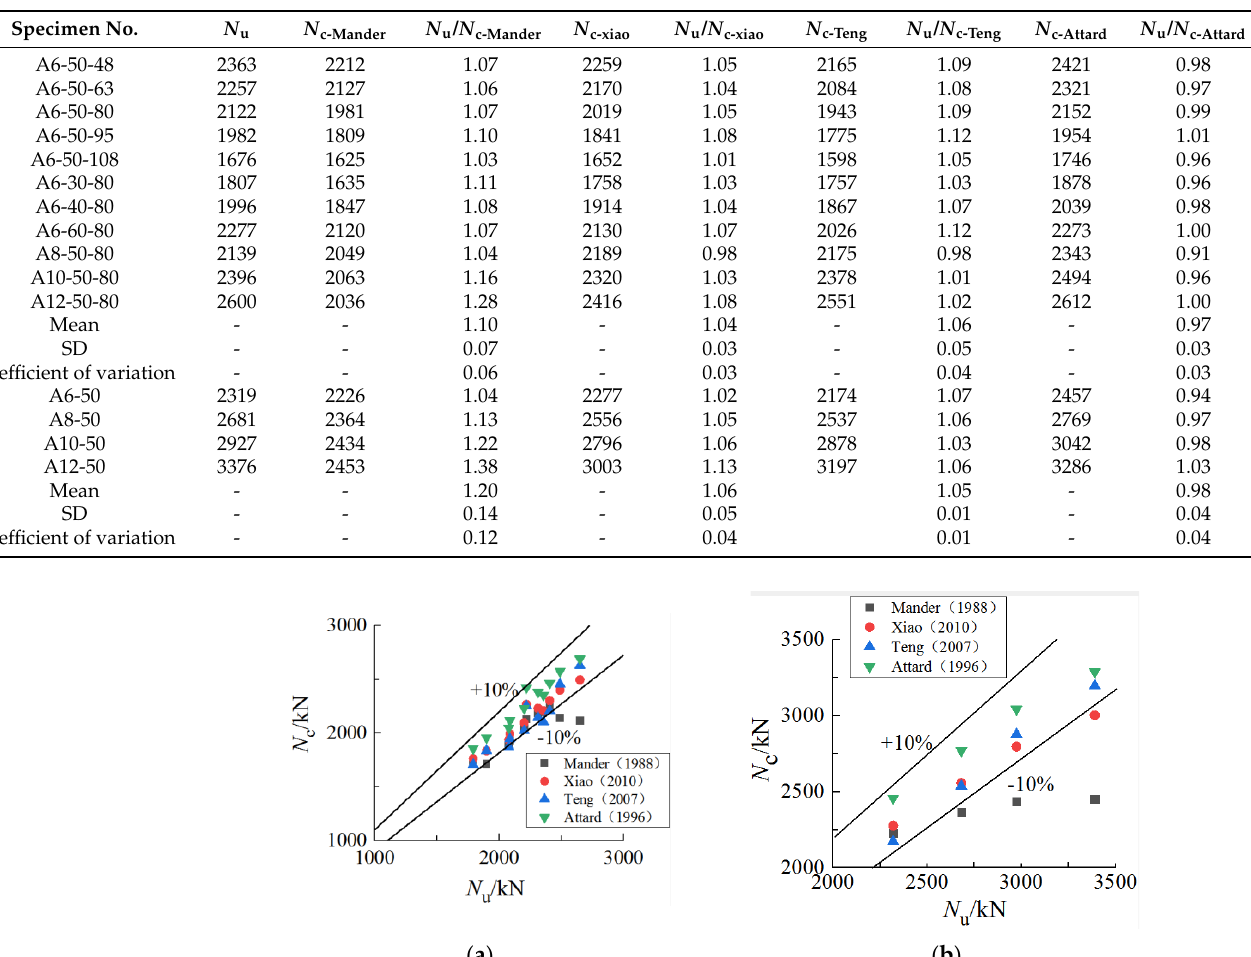
Table 5. Ultimate strength of the tested specimens.